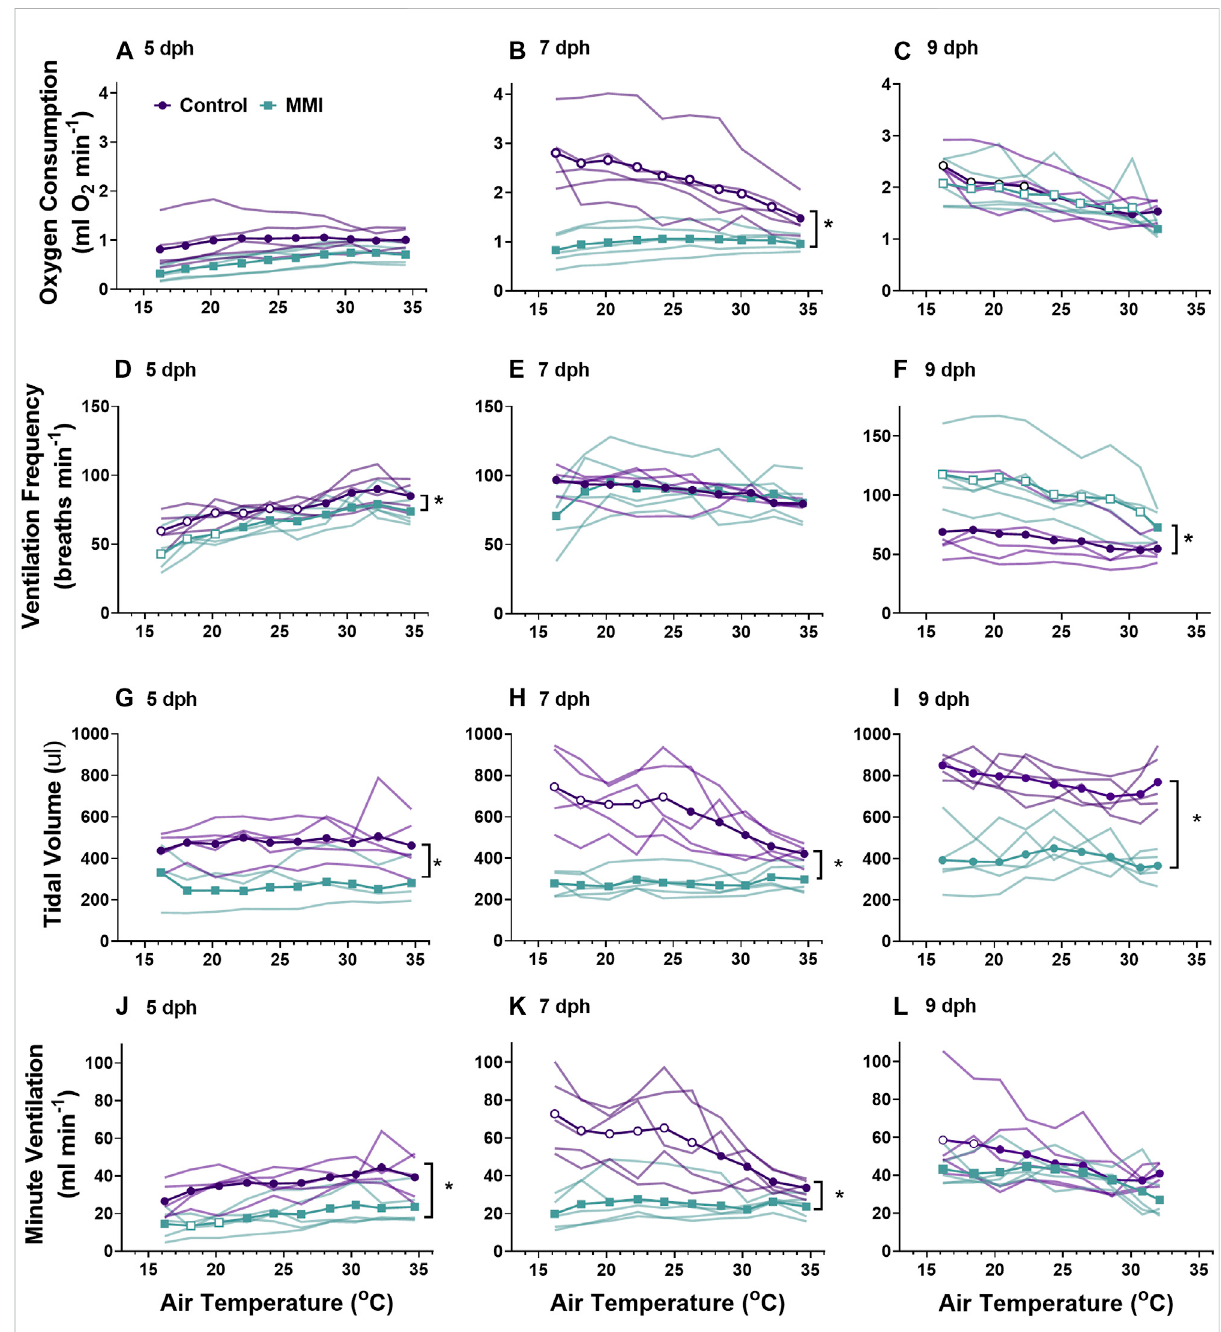
morphology and physiology were observed in response to a hypothyroid condition when compared with the responses in control and hyperthyroid